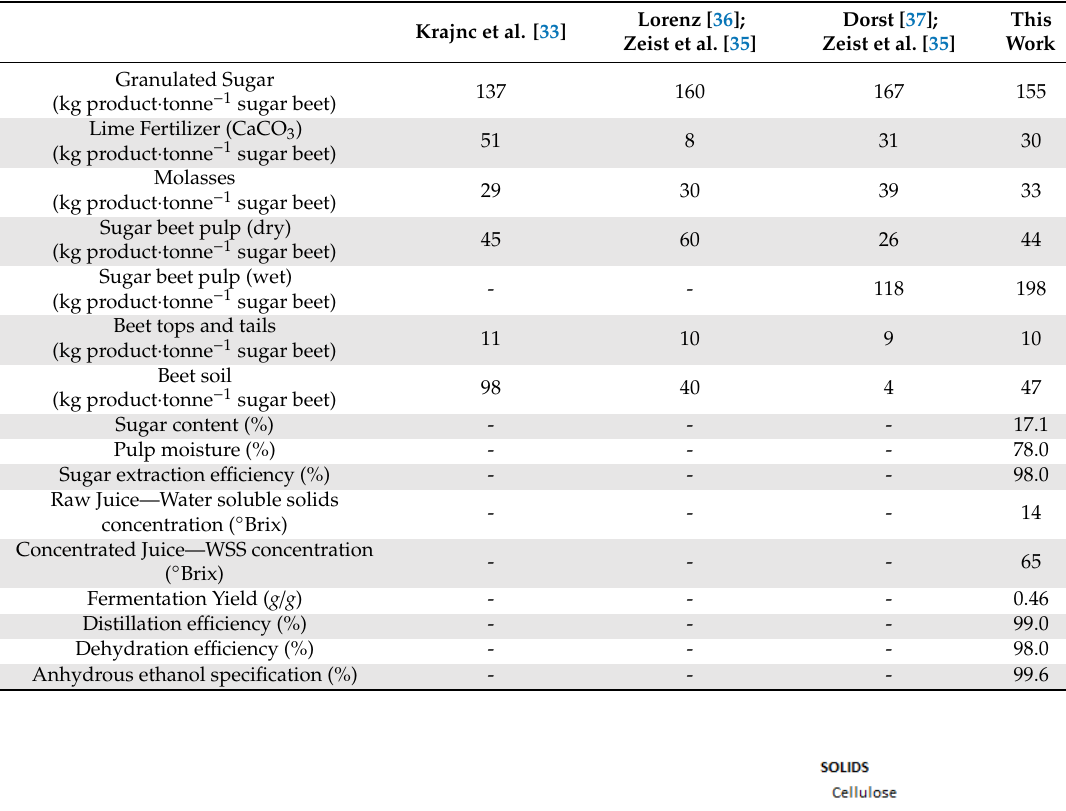
Table 2. Main assumptions considered in the biorefinery simulation.